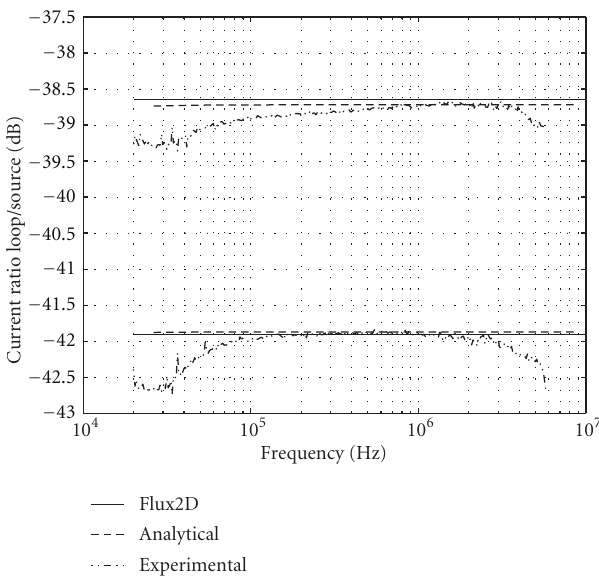
Figure 5: Dipole dB current ratio, sensor Q 20 1 (loop 1).